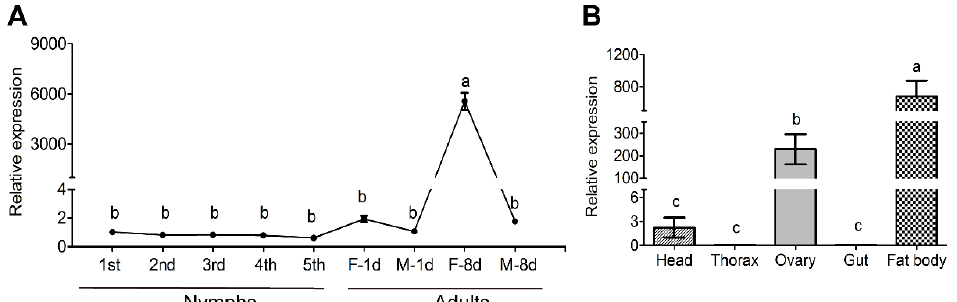
Figure 3. The tissue- and stage-dependent expression profiles of AsAP from the RT-qPCR-based analysis of AsAP transcript levels across different ( A ) developmental stages or ( B ) tissues. The whole bodies of 1st, 2nd, 3rd, 4th and 5th instar nymphs, sexually immature (1-day-old) male and female adults and sexually mature (8-day-old) male and female adults were collected separately to determine the RNA distribution profiles. Samples from the head, thorax, ovary, gut and fat body were collected separately from 8-day-old females. Elongation factor-1 γ (EF1 γ ) was used as a reference gene for the AsAP transcript normalization. The values are expressed as the means ± SEM, based on three independent biological replicates. Different letters show significant differences ( p < 0.05, one-way ANOVA followed by Tukey’s HSD test).